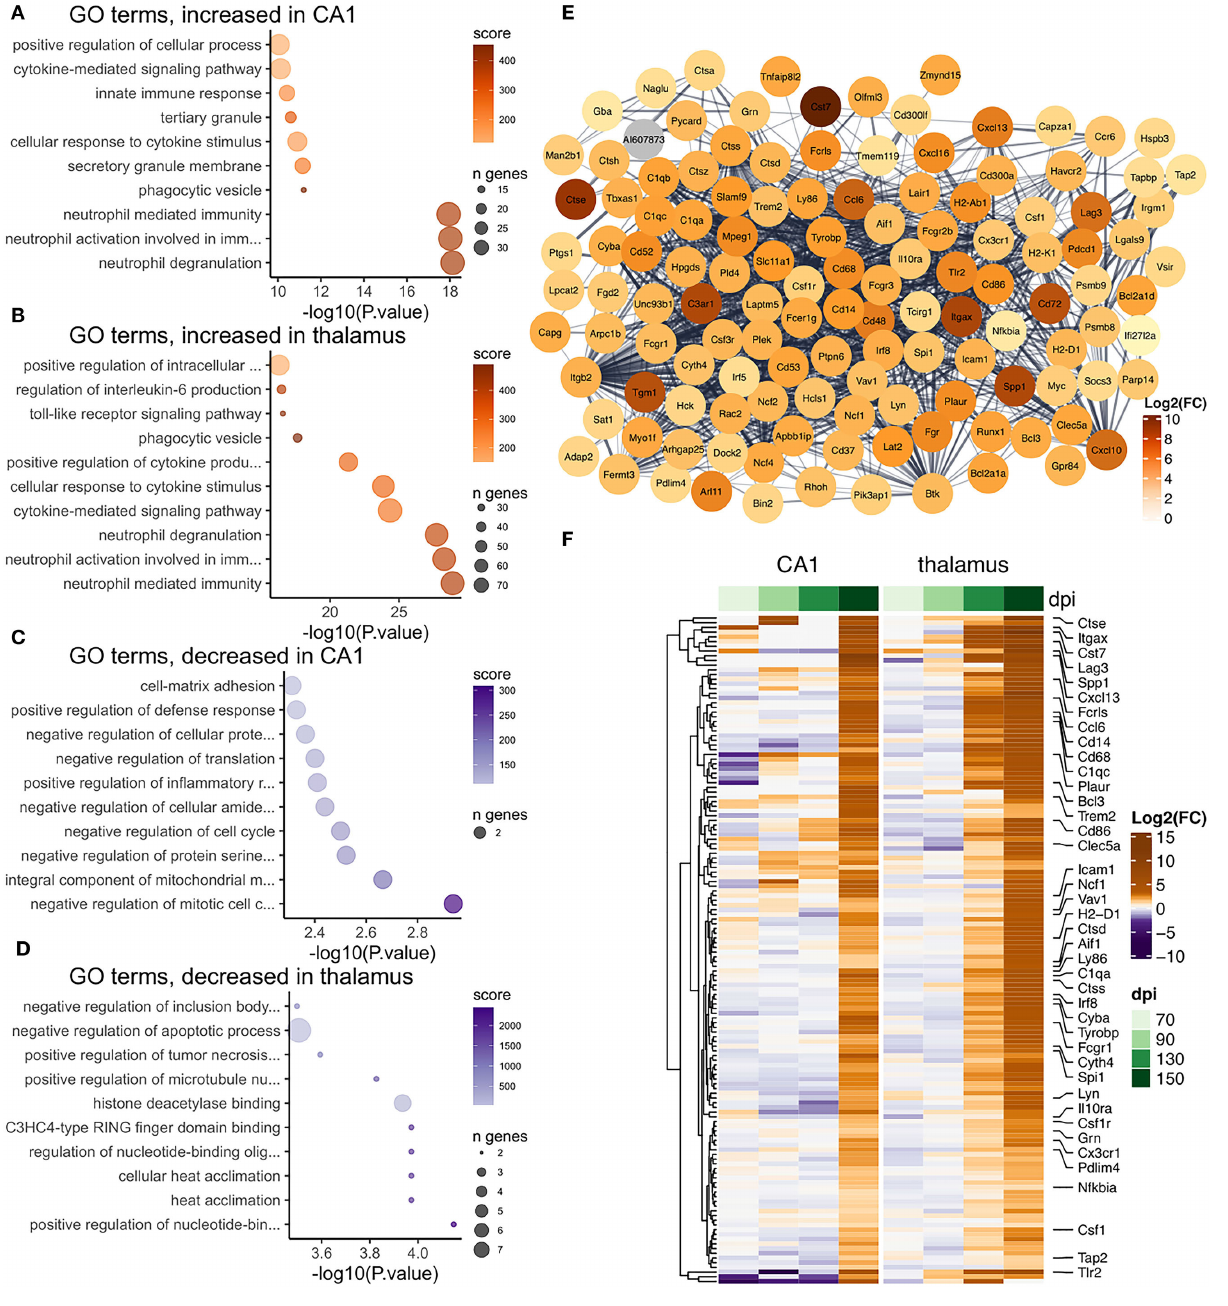
FIGURE 7 | Transcriptional changes affiliated with microglia in the CA1 and thalamus of RML infected mice. Enrichr was used to identify enriched gene ontologies for microglial affiliated transcripts that were (A) increased in the CA1, (B) increased in the thalamus, (C) decreased in the CA1, and (D) decreased in the thalamus. (E) STRING was used to construct a protein-protein interaction network of the 142 microglia transcripts that were commonly prion altered in the CA1 and thalamus. (F) A heatmap was used to visualize magnitude of change, expressed as log 2 fold-changes at each timepoint for the common microglia